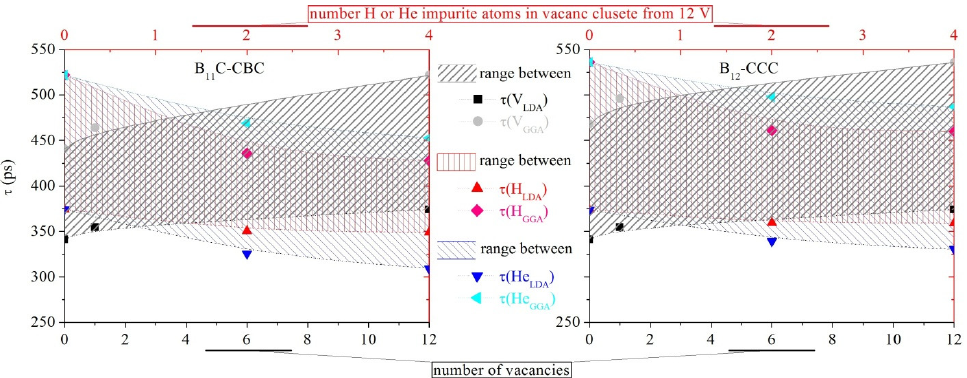
Figure 3. Functional dependencies between τ and number of vacancies or H and He atoms in vacancy cluster from 12 vacancies. These ranged between the τ functions of LDA and GGA methods.